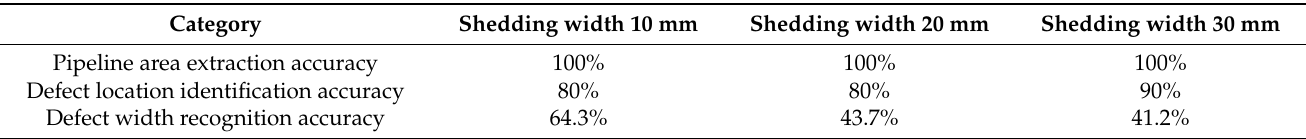
Table 2. Comparison recognition results of different